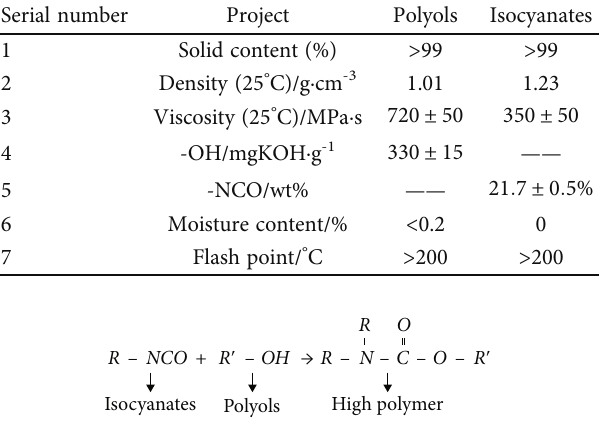
Figure 1: Gel reaction chemical